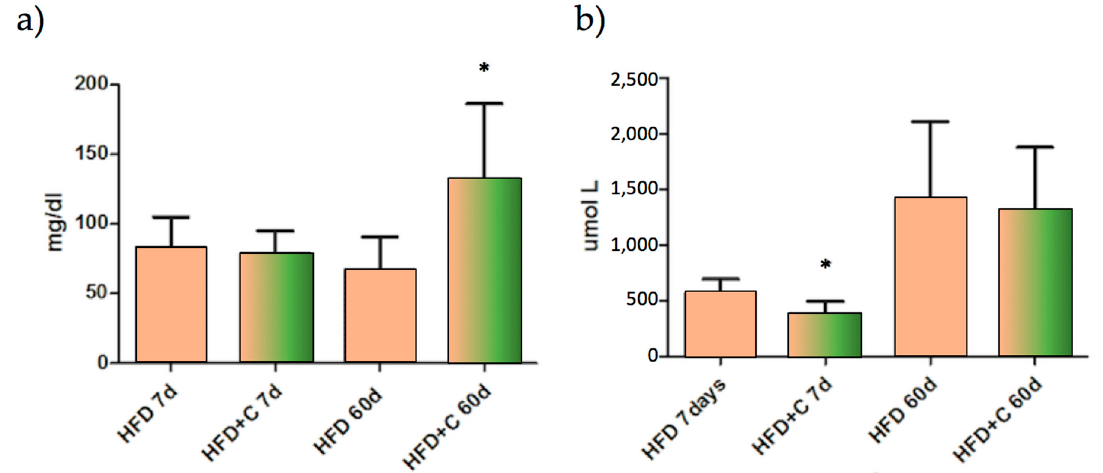
Figure 4. ( a ) Faecal TC showed that values were significantly higher in the HDF + C group compared with the HFD group by the end of the treatment; ( b ) Faecal TBS values comparison between HFD and HFD + C groups. Stars indicate that the values were significantly different ( p < 0.05 with *, p < 0.01 with **, and p < 0.001 with ***, n = 10).